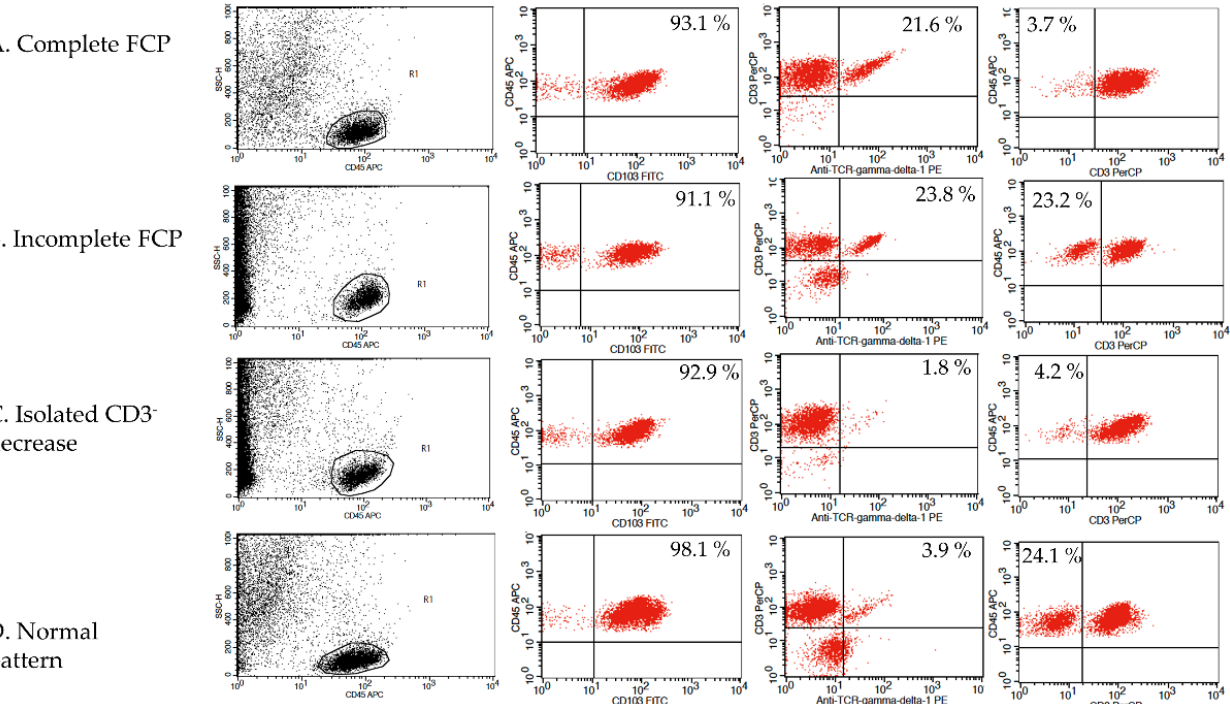
Figure 1. Gating strategy and the four patterns cytometric patterns. Complete and incomplete flow cytometric patterns (FCP) are CD related patterns.